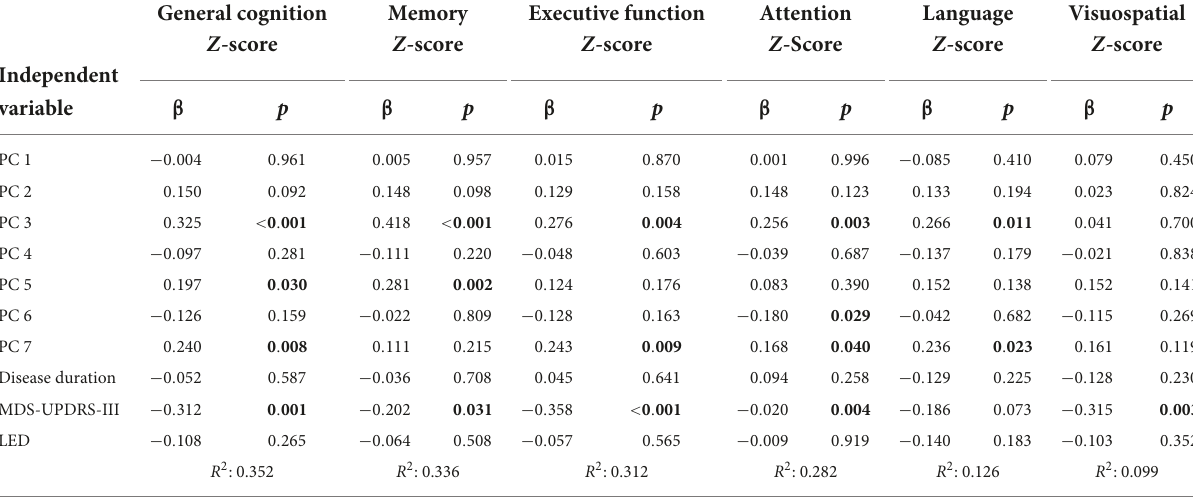
TABLE 2 Regression models for general cognition and domain specific cognitive functioning. General